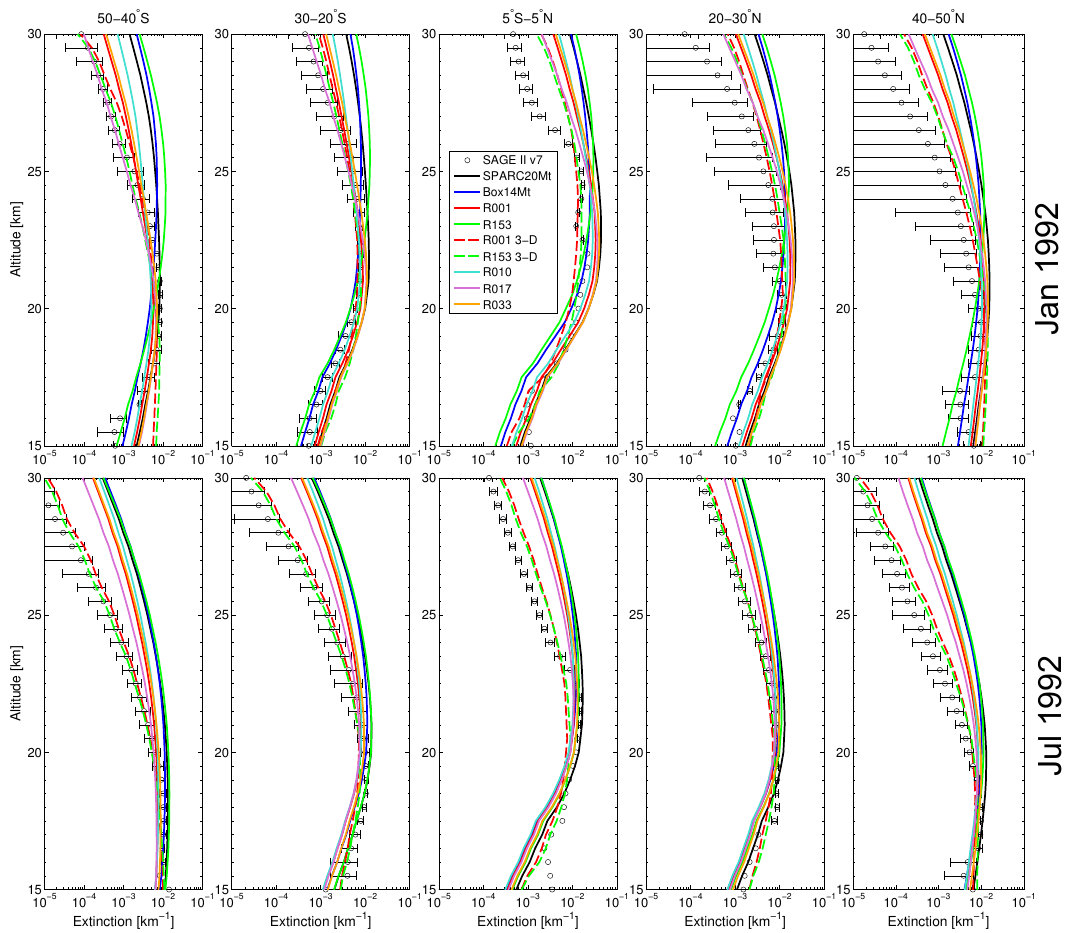
Figure 5. Aerosol 1020nm extinction comparisons of SAGE II (version 7.0) and model simulations in five latitude bands (from left to right) model results. Dashed curves: 3-D SOCOL-AER model results. Symbols with horizontal bars: SAGE II extinction measurements with bars indicating natural variability (namely observed zonal differences). Symbols without horizontal bars: data from individual ground-based lidar stations used within SAGE-4 λ under conditions when the atmosphere was so opaque that SAGE II could not measure it; so-called gap-filled data with large uncertainty (SPARC, 2006; Luo,